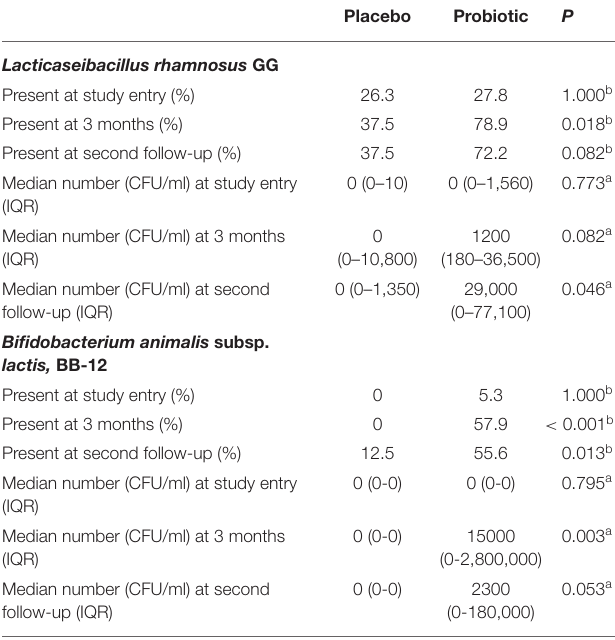
TABLE 3 | Anti-seasonal influenza antibody titres, seroprotection and seroconversion in participants in the placebo and probiotic groups. Placebo ( n =